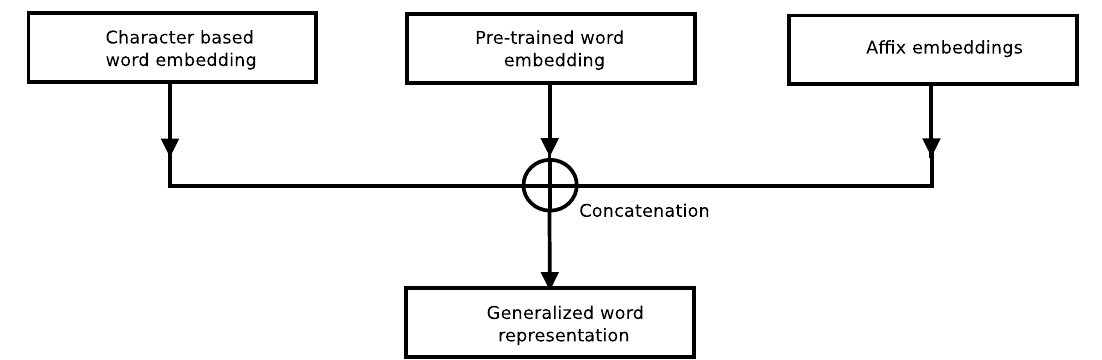
Figure 2. Generalized word